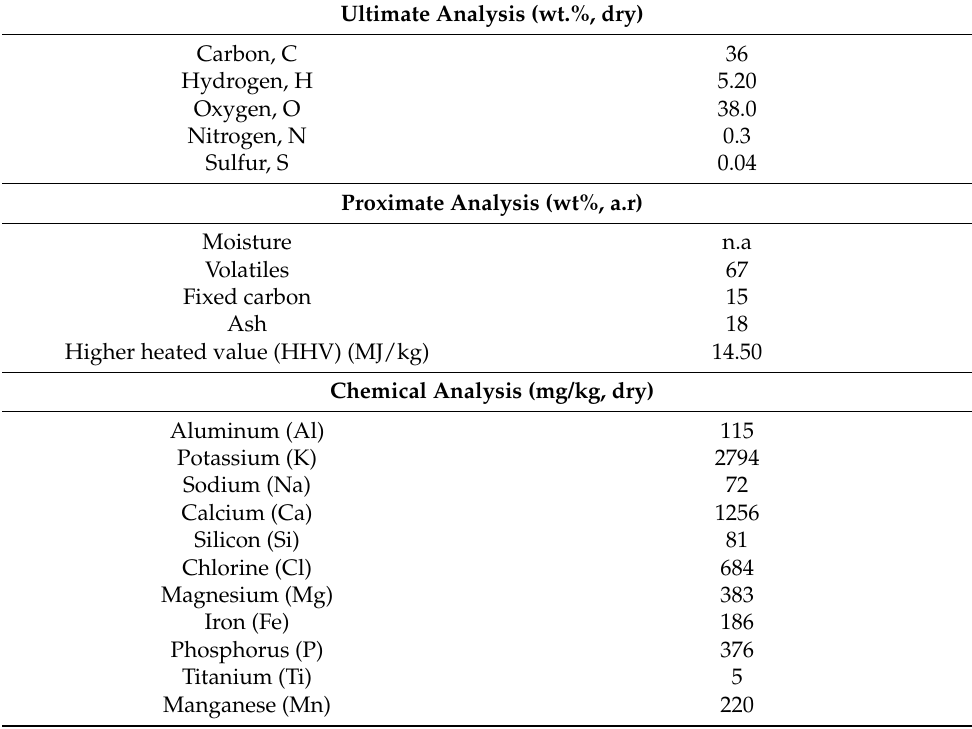
Table 1. Ultimate and proximate and chemical analysis of rice husk (RH) [6].